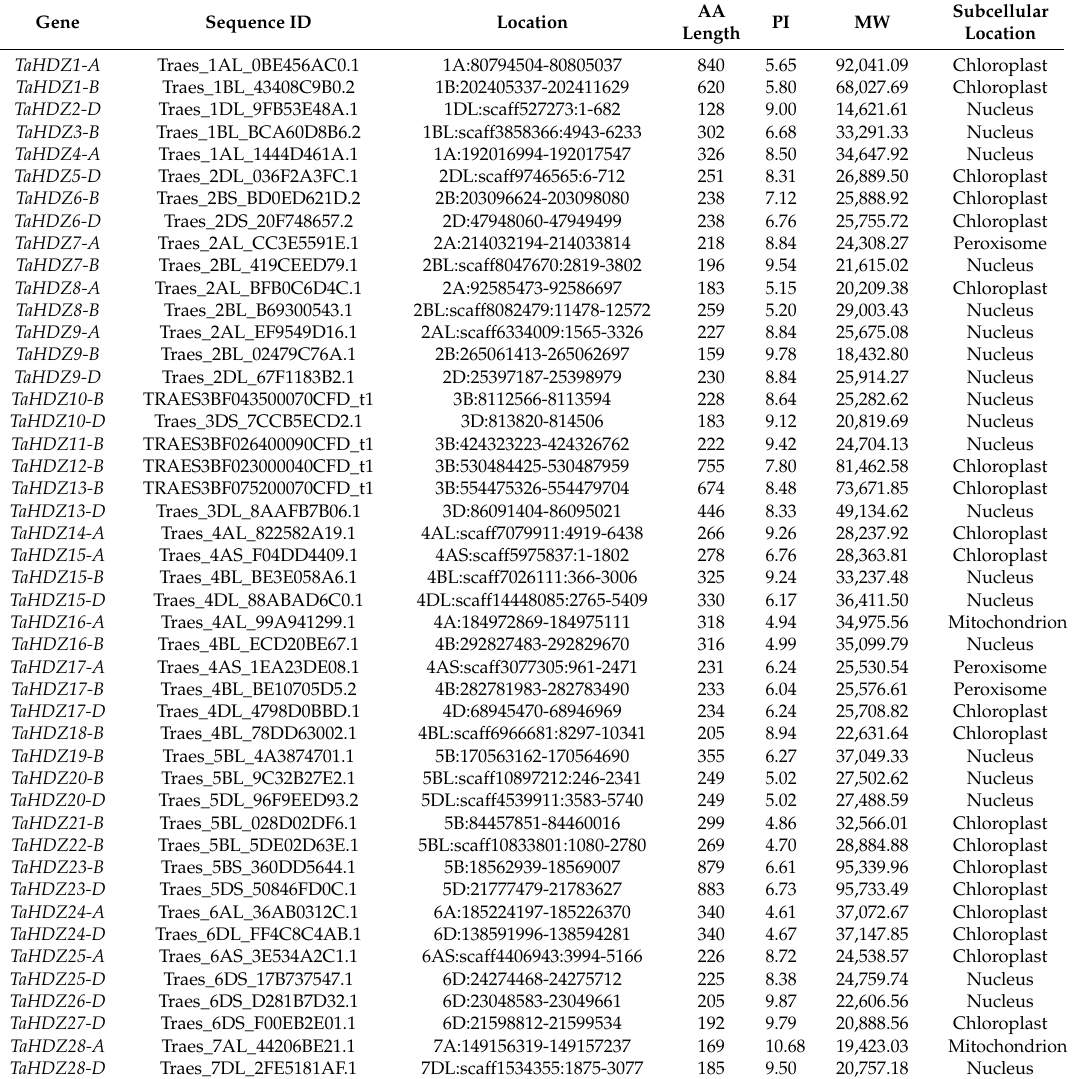
Table 1. Characteristics of the putative homeodomain-leucine zipper (HD-Zip) proteins in wheat. Gene Sequence ID